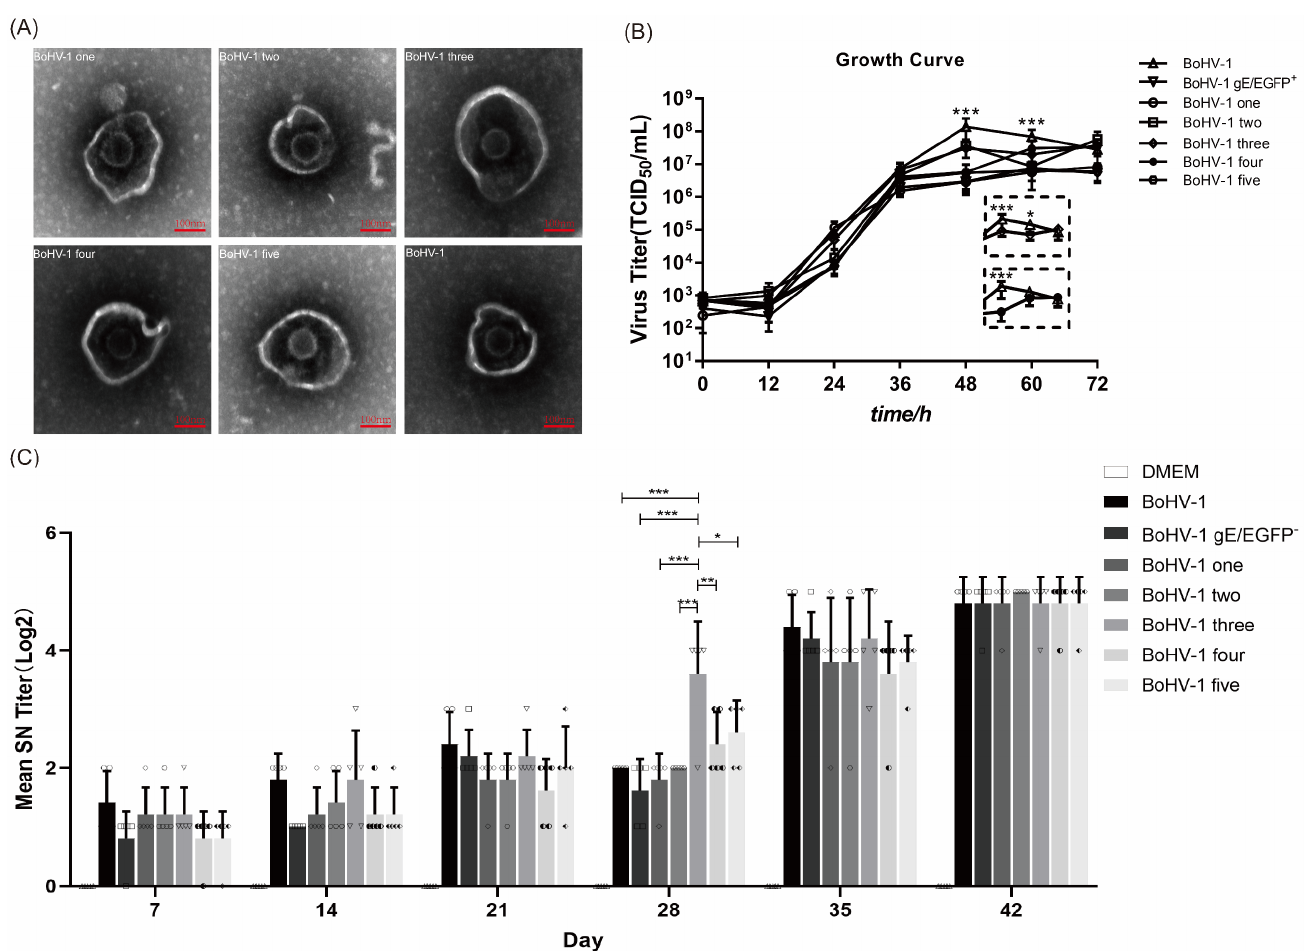
Figure 5. The insertion of genes did not change the replication, morphology or immunogenicity of the virus. ( A ) After staining with phosphotungstic acid, the morphology of BoHV-1 was compared with that of other mutant viruses using an electron microscope. ( B ) BoHV-1, BoHV-1 gE/EGFP − , and other recombinant viruses inoculate MDBK cells at 0.01 MOI. At 12, 24, 36, 48, 60, and 72 hpi after inoculation, the Karber method was used to calculate the virus titer and draw the virus growth curve. Windows shows the respective titers of parental BoHV-1, mutant three and four at 48, 60 and 72 h post infection. ( C ) The virus was injected intramuscularly, and the second immunization was performed at 21 d after the first immunization. Serum was collected every 7 days after the initial immunization to detect specific neutralizing antibodies against BoHV-1. *** p < 0.001, ** p < 0.01, * p < 0.05. Each graph represents the neutralizing antibody titer of each mouse in different immunization groups. Circle: BoHV-1; Square: BoHV-1 gE/EGFP-; Diamond: BoHV-1 one; Hexagon: BoHV-1 two; Inverted triangle: BoHV-1 three; Left half-solid hexagon: BoHV- 1 four; left half filled diamond: BoHV-1 five.